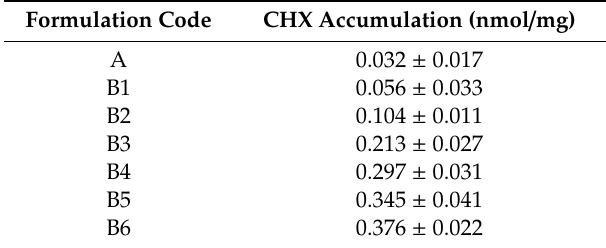
Table 2. Quantitation of CHX post cornea accumulation by HPLC analysis. Formulation code